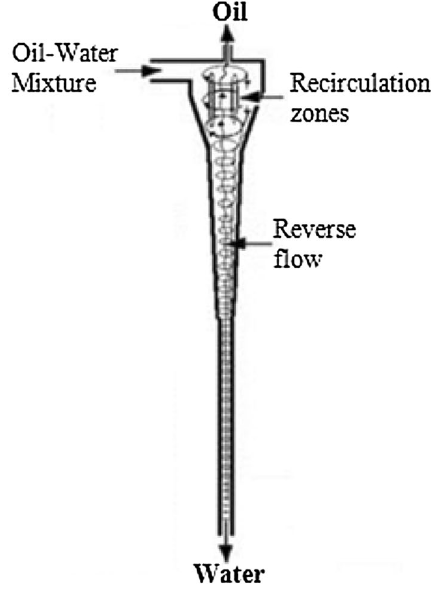
Fig. 1 LLHC hydrodynamic flow behaviour (Gomez et al.